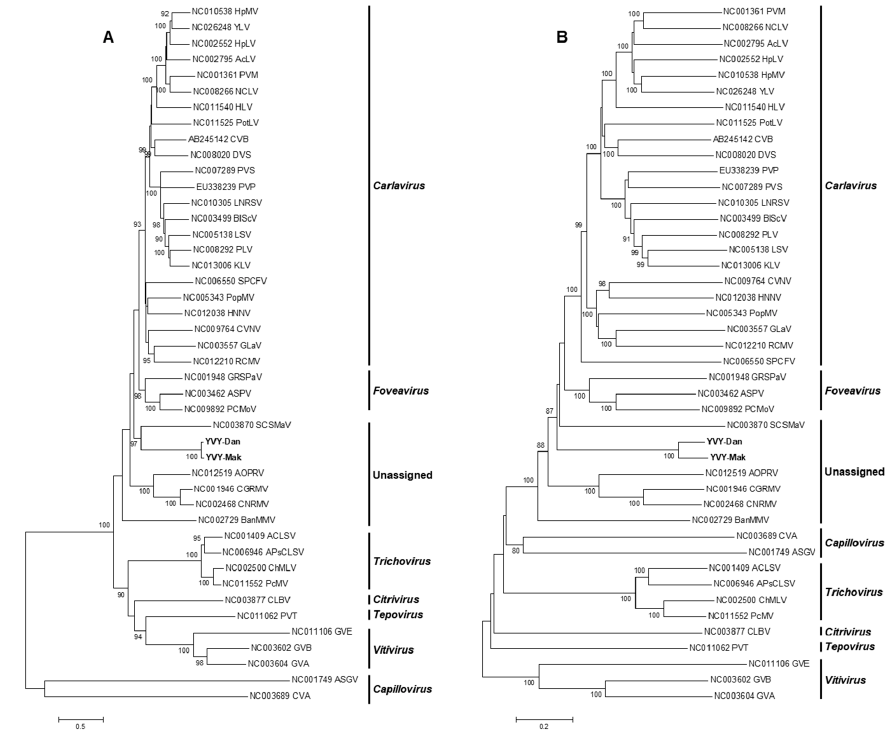
Figure 2. Phylogenetic trees based on ( A ) the amino acid sequences of the entire replicase protein and ( B ) full-genome sequences of YVY-Dan and YVY-Mak and members of the family Betaflexiviridae . Bootstrap analysis was performed with 1000 replicates and the cut-off value was 85%. The scale bar represents the number of amino acid and nucleotide substitutions per site. YVY-Dan and YVY-Mak are indicated in bold.